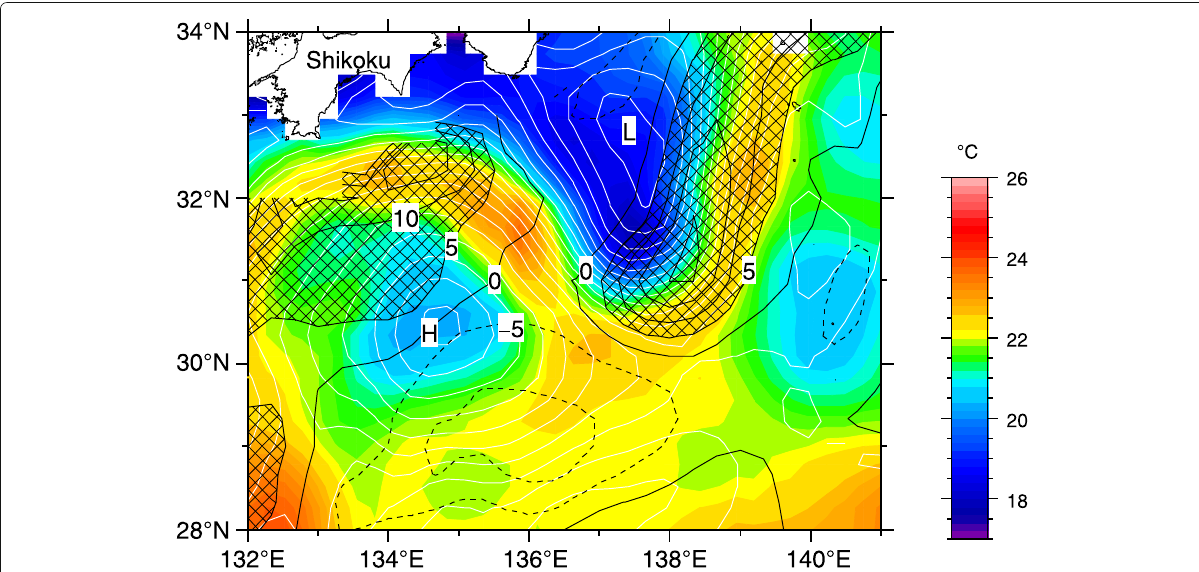
Fig. 12 Sea surface current divergence (10 − 6 s − 1 , black contours), sea surface temperature ( ◦ C, color shading), and sea surface height (cm, white contours). Contour intervals of current divergence and SSH are 5 × 10 − 6 s − 1 and 10cm, respectively. Meshing indicates regions where